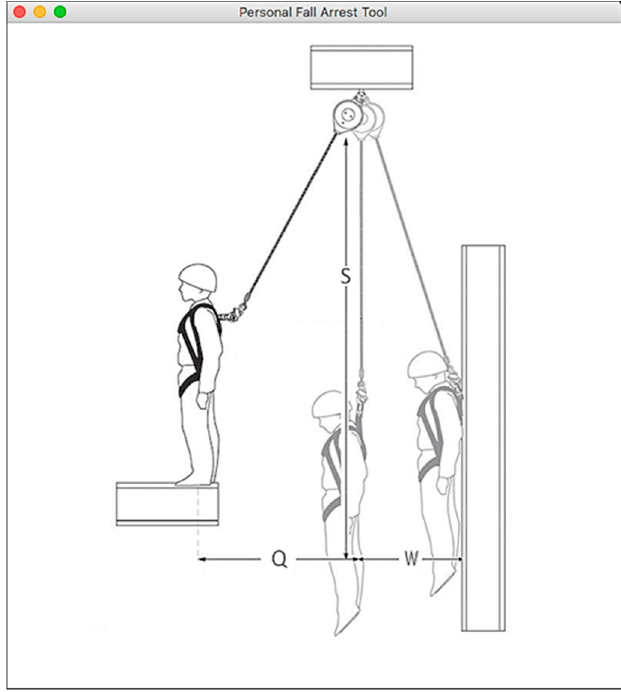
Figure 5. Swing hazard guide (adapted from ANSI/ASSE [14]).